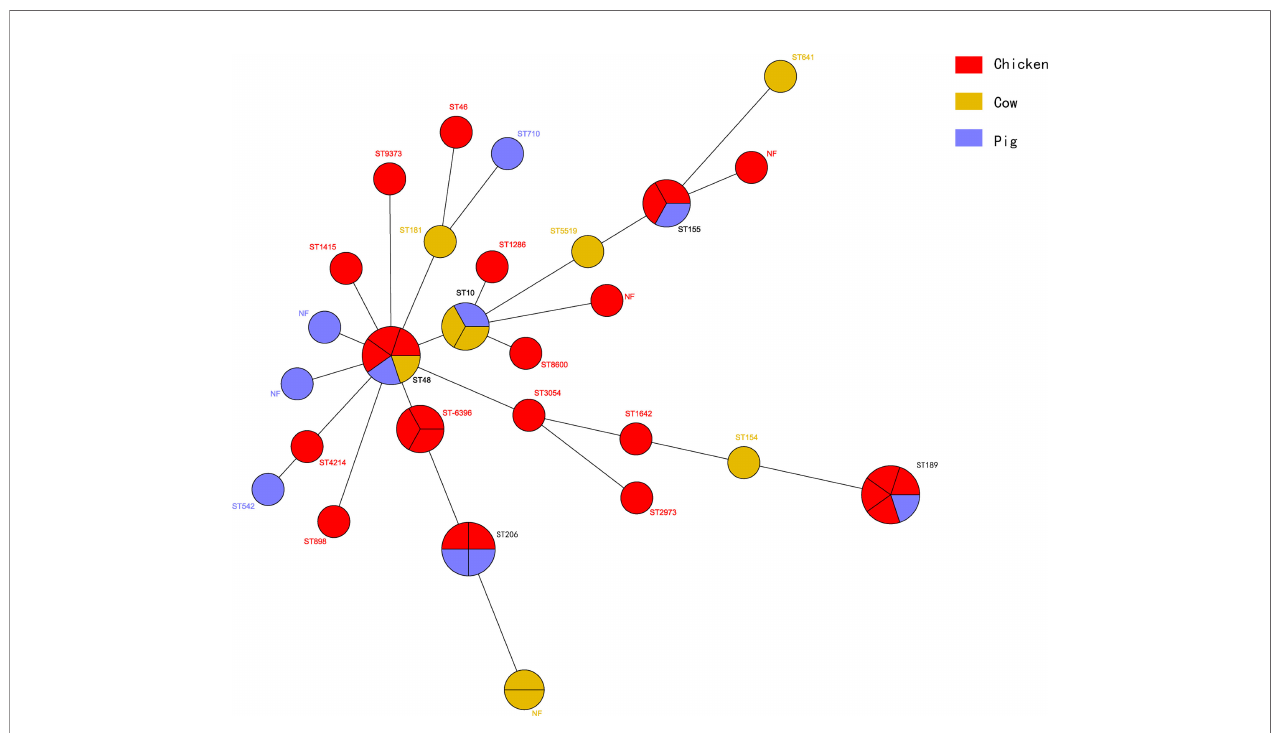
FIGURE 4 | Phylogenetic analysis of STs among 45 ESBL-EC isolates. The clones from chicken ( n = 26) were colored red, while those of cow ( n = 9) yellow and those of pig ( n = 10)